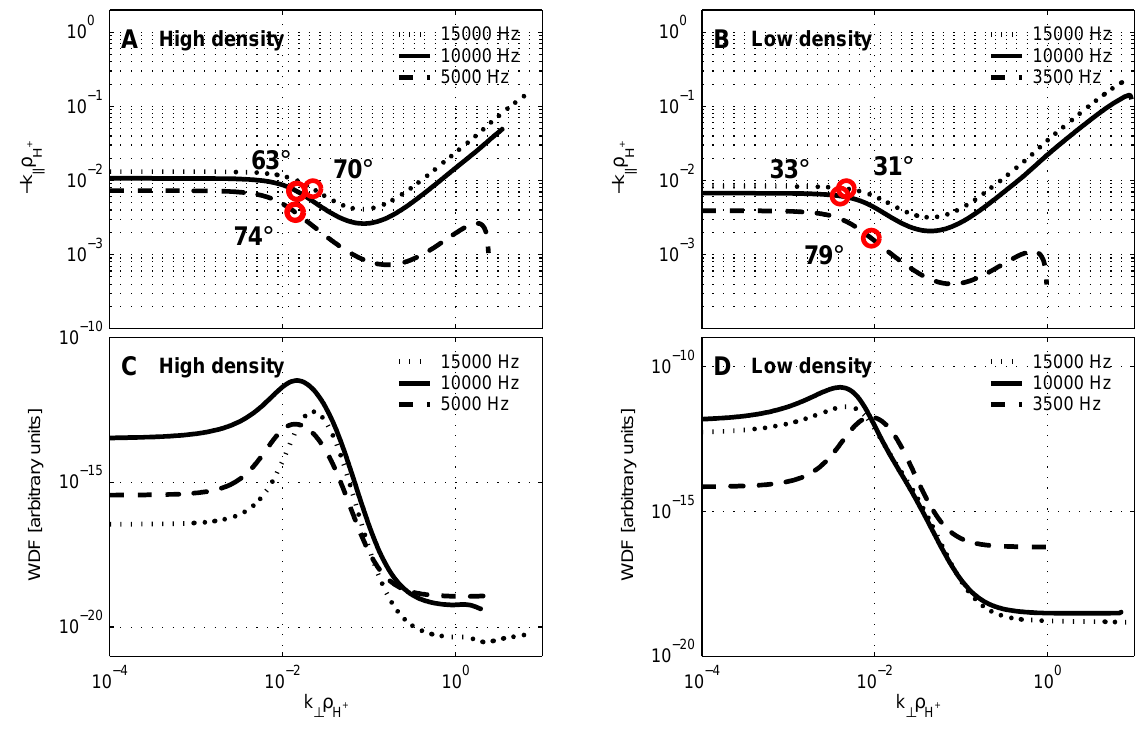
Fig. 10. The peaks in the reconstructed WDF are presented on top of constant frequency curves in the wave vector space in panels (A) and (B) . In panels (C) and (D) the WDF is plotted versus normalized k ⊥ . As before ρ H + =7m. the two cases is 3100 cm − 3 and 7900 cm − 3 , respectively.